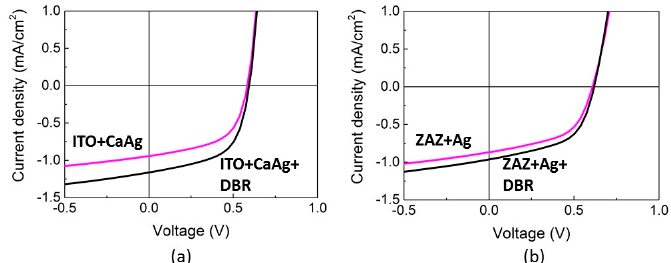
Figure 8. Effect of a DBR on the device performance of transparent solar cells with different top and bottom electrodes. ( a ) Device performance of ITO and Ca:Ag based solar cells with or without DBR. ( b ) Device performance of ZAZ and Ag based solar cells with or without DBR.